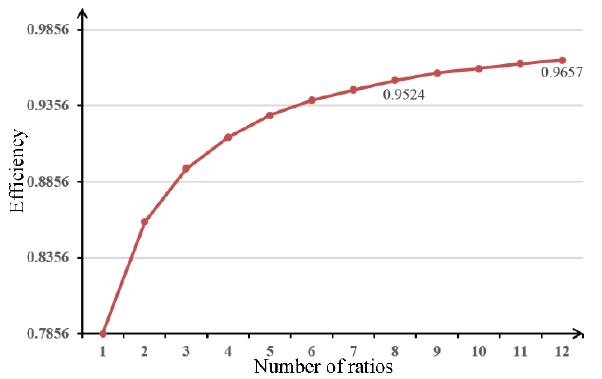
Figure 7. Variation of HDCPLN working efficiency with the number of transformation ratios.